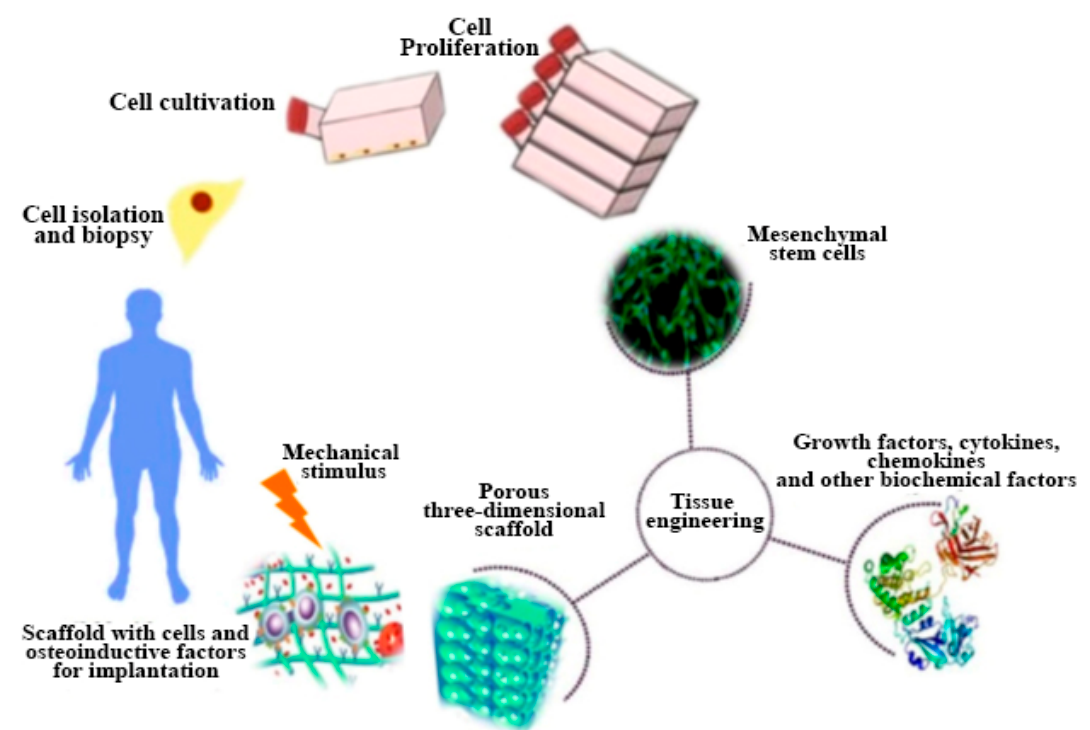
Figure 8. Schematic representation of bone tissue engineering [64].